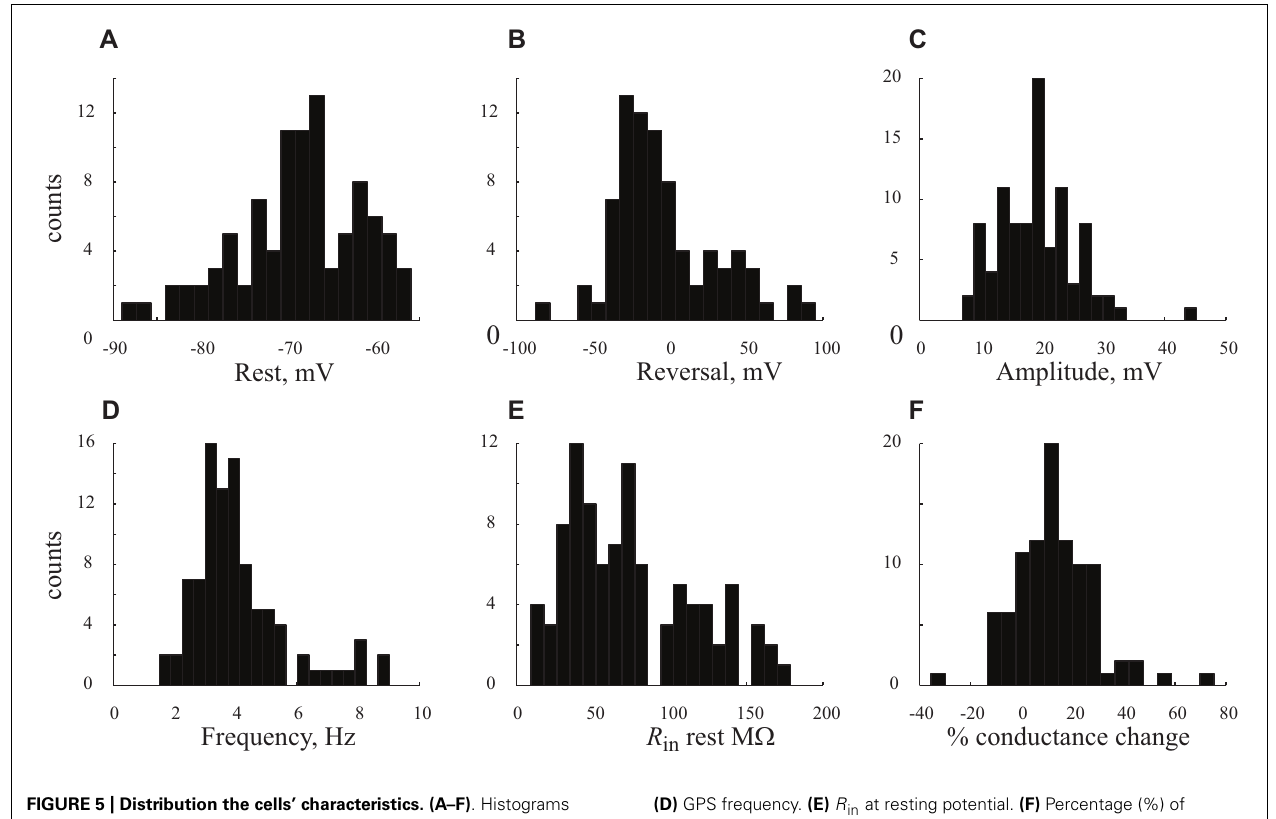
(D) GPS frequency. (E) R in at resting potential. (F) Percentage (%) of conductance change between resting potential and peak of GSP. Note the unimodal distributions of all the parameters.